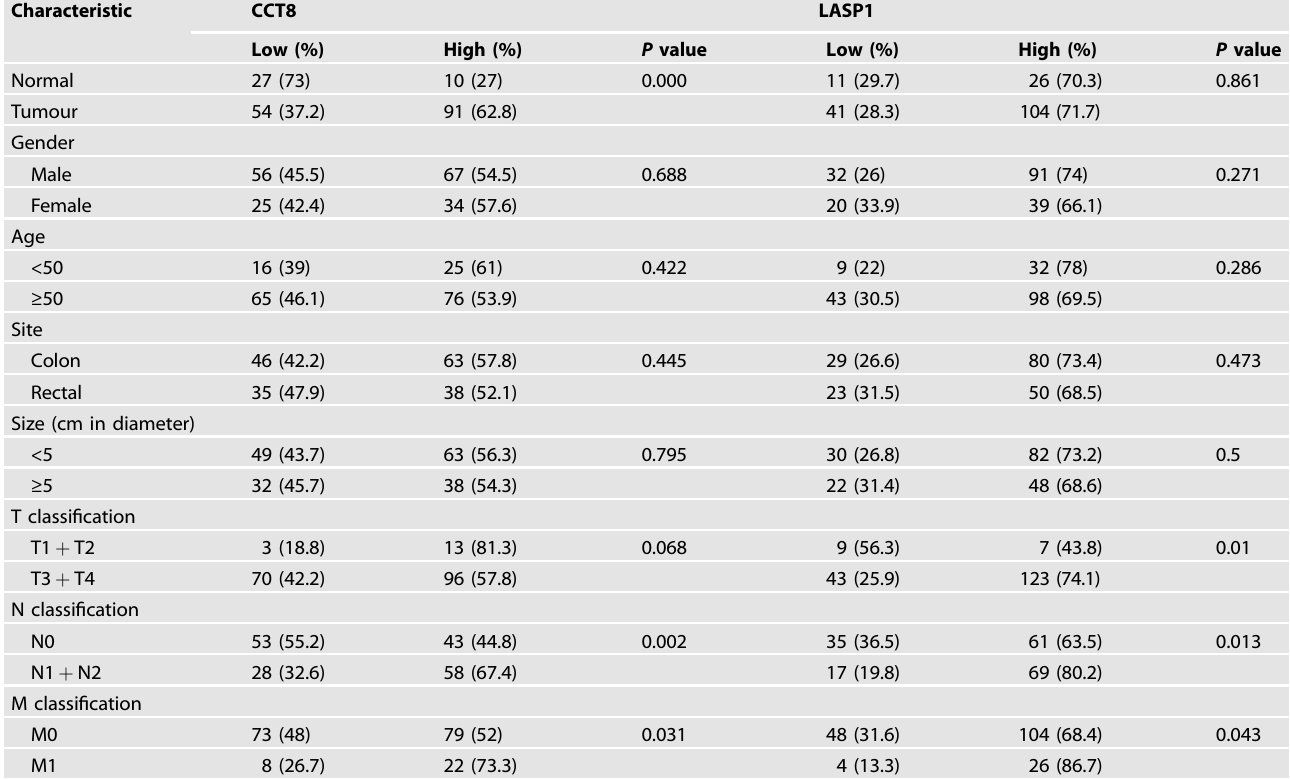
Table 1. Correlation of different parameters with CCT8 and LASP1 expression.